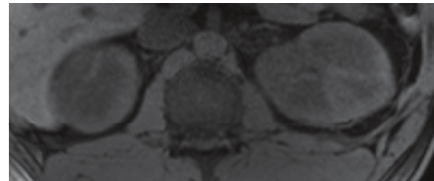
Figure 2: Axial fat-saturated T1w precontrast image of the kidneys: the unenhanced image does not provide dynamic information regarding the kidneys’ uptake and excretion of